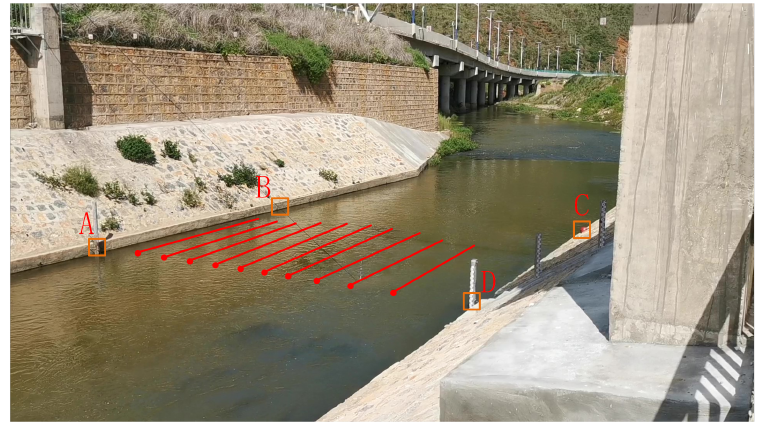
Figure 18. Layout diagram of the ground mark and search lines. Table 10. Sectional data of the Dali